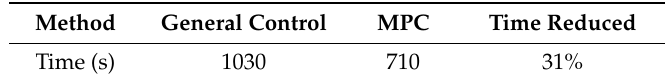
Figure 27. Comparison of actual current measurement. ( a ) Based on the general control method; ( b ) Based on the MPC method. Table 2. Equilibrium time comparison.